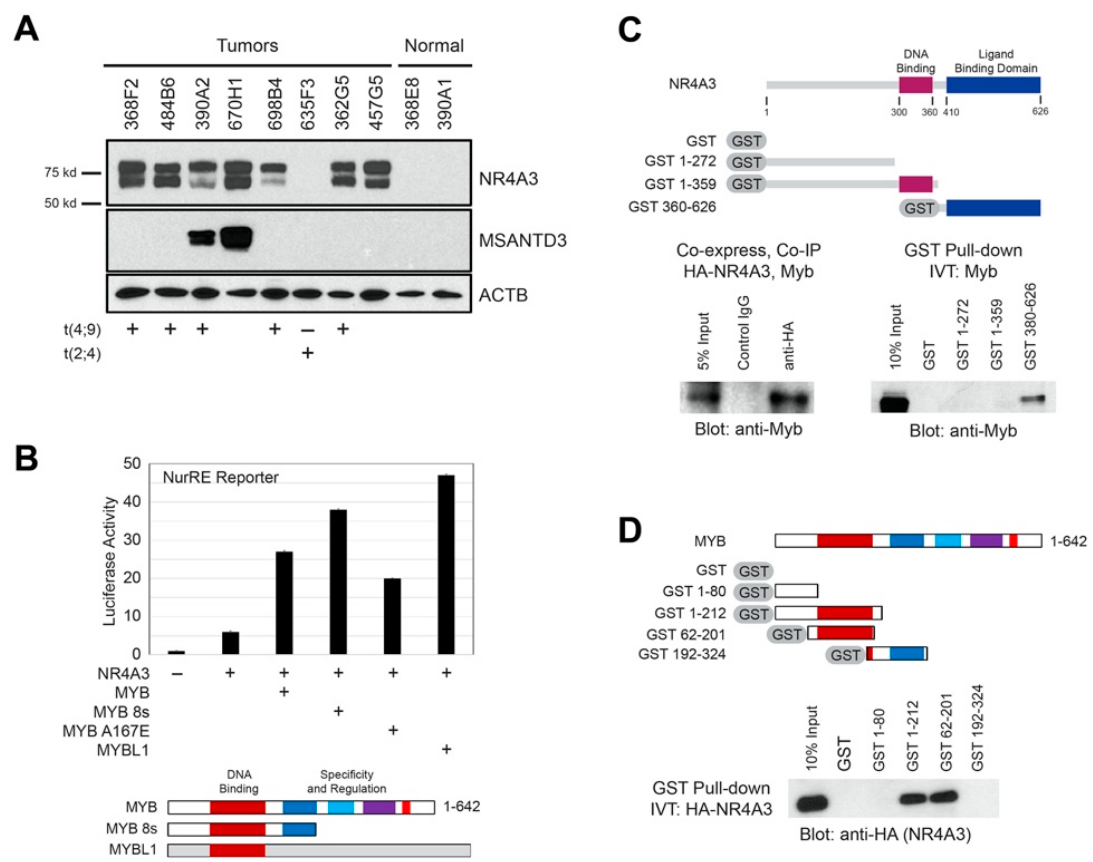
Figure 4. NR4A3 and MYB cooperate and interact. ( A ) Western blot analysis. Sample identifiers are shown at top, antibodies used to probe the blot are indicated at right. An actin loading control is shown at the bottom. The fusions that were detected (‘ + ’) or not detected (‘–’) by either RNA-seq or FISH are indicated along the bottom (blanks were not tested). High expression of NR4A3 protein was detected in all samples with t(4;9), but not in the normal samples (right) or the sample with t(2;4), which expressed the NR4A2 gene instead. Two distinct NR4A3 proteins were detected; the main form (approximately 68kD, lower band) and an isoform (approximately 80kD, upper band). MSANTD3 protein was detected in the two samples that also had fusions activating that gene (390A2 and 670H1); ( B ) NR4A3 and Myb cooperate. HeLa cells were transfected with the NuRE promoter–luciferase vector plus plasmids expressing NR4A3 alone or with di ff erent Myb constructs, as indicated. The Myb proteins are diagrammed at the bottom. Additional controls are in Figure S5; ( C ) NR4A3 pull-down assays. The NR4A3 protein is diagrammed at top, including the DNA binding (red) and ligand binding (blue) domains. GST fusion proteins used for pull-down assays are diagrammed. Left panel: Cos-7 cells were co-transfected with plasmids expressing HA-tagged NR4A3 or Myb, protein complexes were immunoprecipitated using control IgG or anti-HA tag antibodies, and the complexes were detected by western blot using anti-Myb antibodies. Right panel: Myb protein was in vitro translated (IVT) and incubated with GST alone or GST-NR4A3 fusion proteins as indicated. The GST-bound complexes were isolated and assayed by western blot using anti-Myb antibodies; ( D ) Myb pull-down assays. The Myb protein is diagrammed, with several conserved domains shaded. GST fusion protein constructs are diagrammed. HA-tagged NR4A3 protein generated by in vitro translation was incubated with GST-Myb fusion proteins. The GST-bound complexes were isolated and assayed by western blot using anti-HA